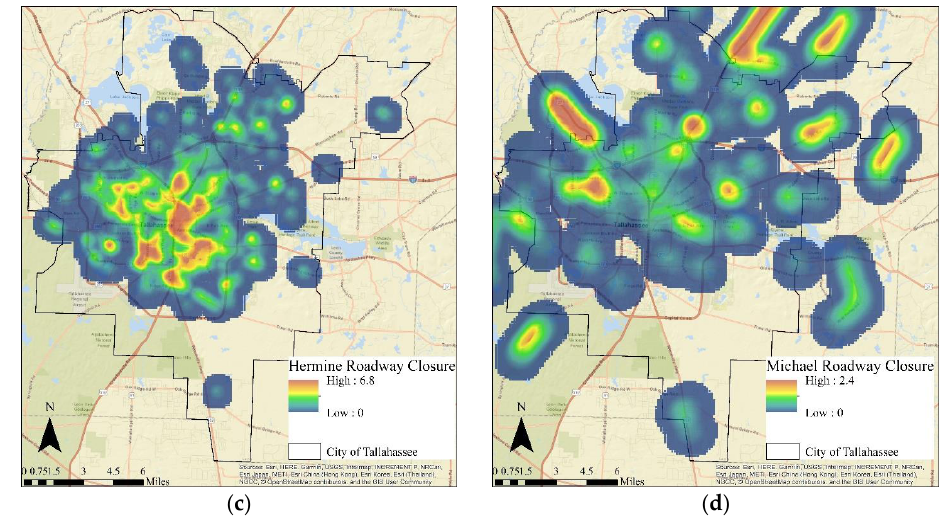
Figure 5. Power outages cause by Hermine (bandwidth: 200 meters) (a) ; power outages cause by Michael (b) ; roadway closures cause by Hermine (c) ; roadway closures caused by Michael (d) . Note that areas in red show higher risk locations for power outages and roadway closures during both hurricanes.